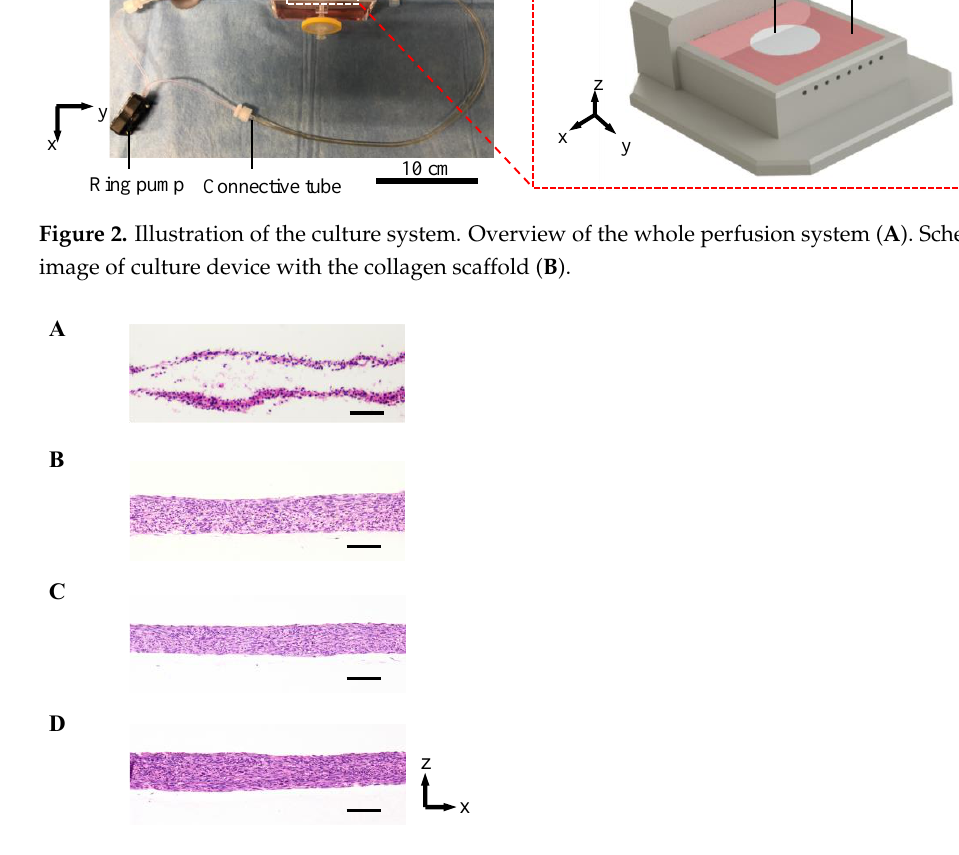
Figure 3. The densities of the cell tissue cultured for 3 d with each method. HE stained cross-section views with the cell tissue culture on a general dish ( A ) and collagen gel with perfusion rates of 0 ( B ), 0.3 ( C ), and 0.5 ( D ) mL/min. Scale bars indicate 100 µm. Figure A2 in Appendix B shows the reproducibility of the results with the cell tissue culture on a general dish and collagen gel with a 0.5-mL/min perfusion